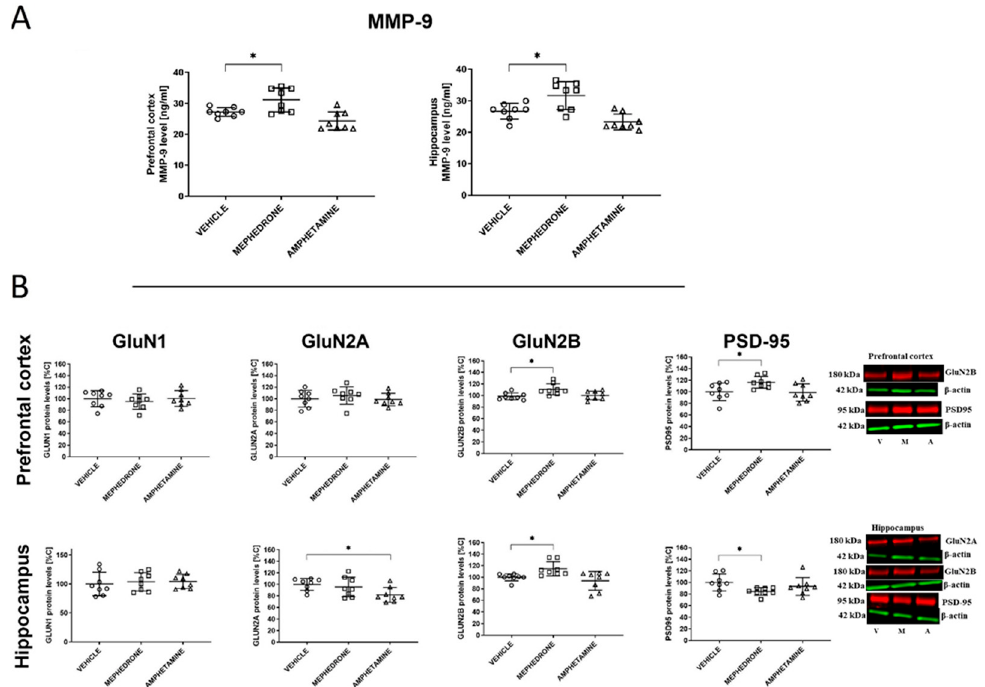
Figure 4. Effect of repeated mephedrone or amphetamine administration during adolescence on MMP-9 ( A ) and NMDA subunits (GluN1, GluN2A, GluN2B) and PSD-95 ( B ) expression in the prefrontal cortex (PC) and hippocampus (HC) of rats (PND 87) that underwent the Barnes maze task. Representative blots for significant changes are presented, as well as full membranes are presented in the supplementary material (Figure S1). Data are expressed as mean ± SEM. n = 8 rats/group. * p < 0.05 vs vehicle (0.9% NaCl). V—vehicle, M—mephedrone, A—amphetamine.